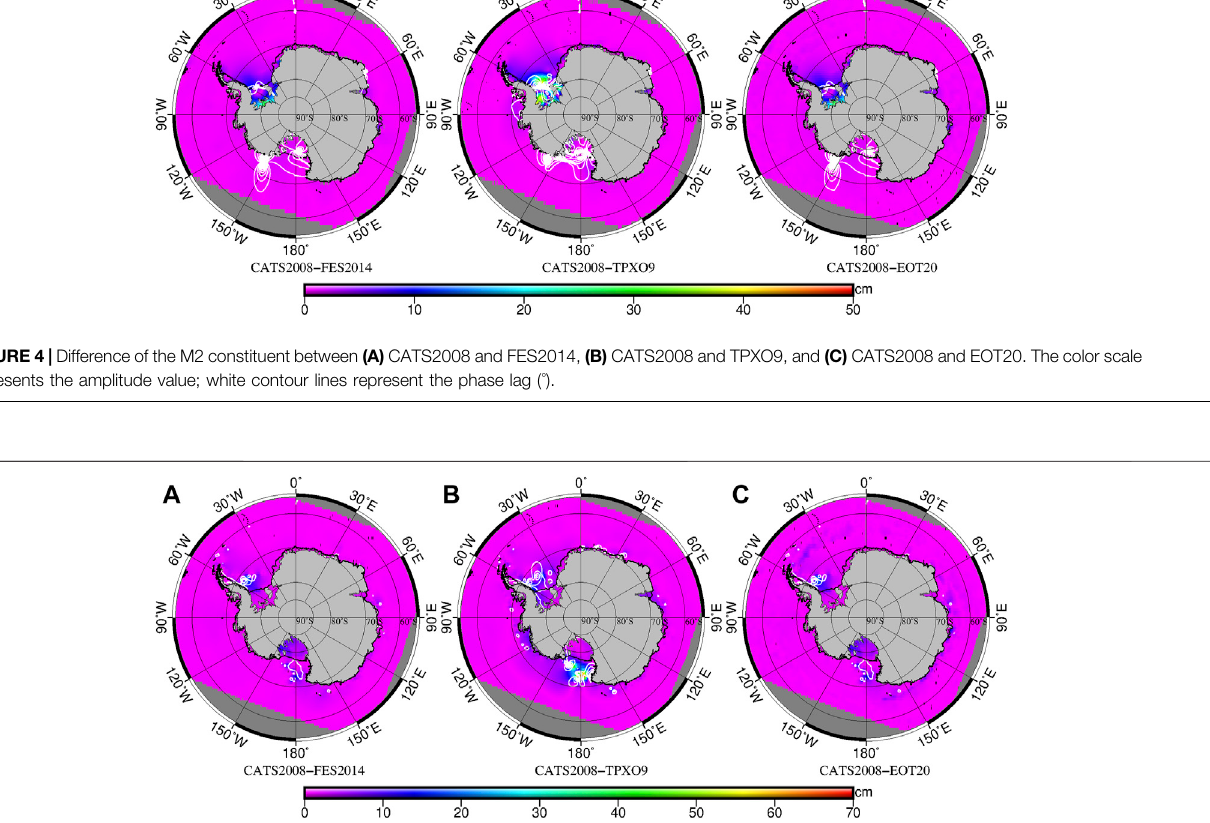
FIGURE 5 | Difference of the K1 constituent between (A) CATS2008 and FES2014, (B) CATS2008 and TPXO9, and (C) CATS2008 and EOT20. The color scale represents the amplitude value; white contour lines represent the phase lag ( ° ).